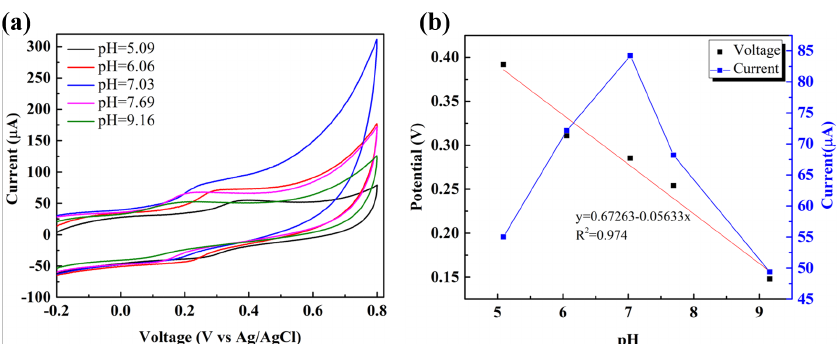
Figure 7. ( a ) CV profiles obtained at various pH values and ( b ) dependence of the oxidation peak potential and current on the various pH values for dopamine detection (100 µM) by BT/rGO at a scan rate of 100 mV/s.